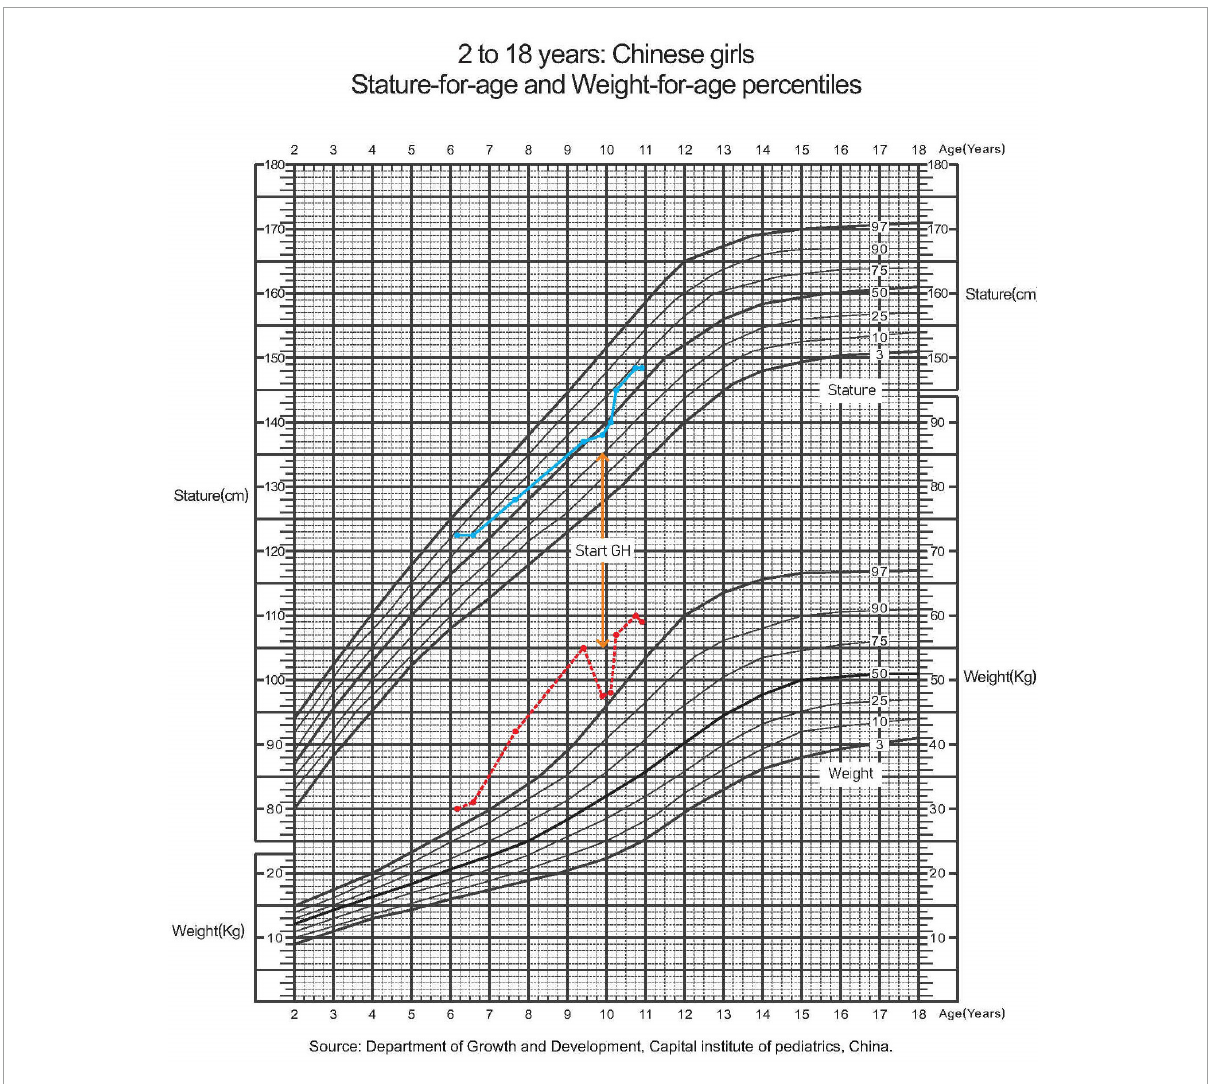
FIGURE2 A growth curve showing stature and weight for age. Dotted line in red, weight; solid line in blue,